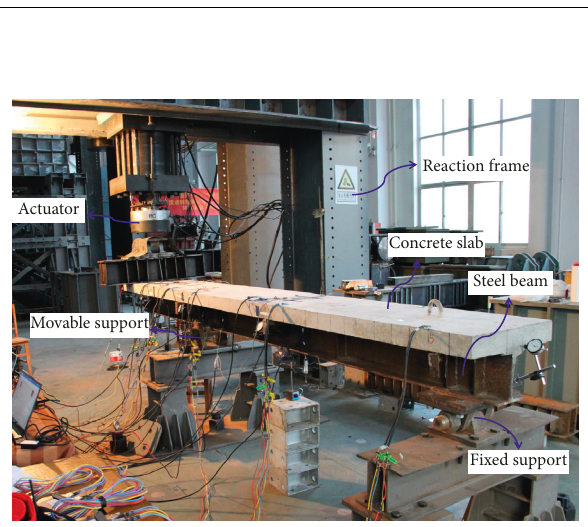
Figure 4: Experimental setup.